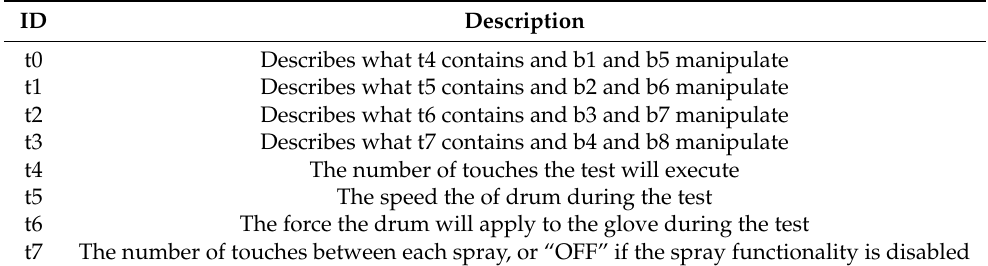
Figure 2. Homepage of LED touchscreen. Table 1. Description of each text field found on the homepage.